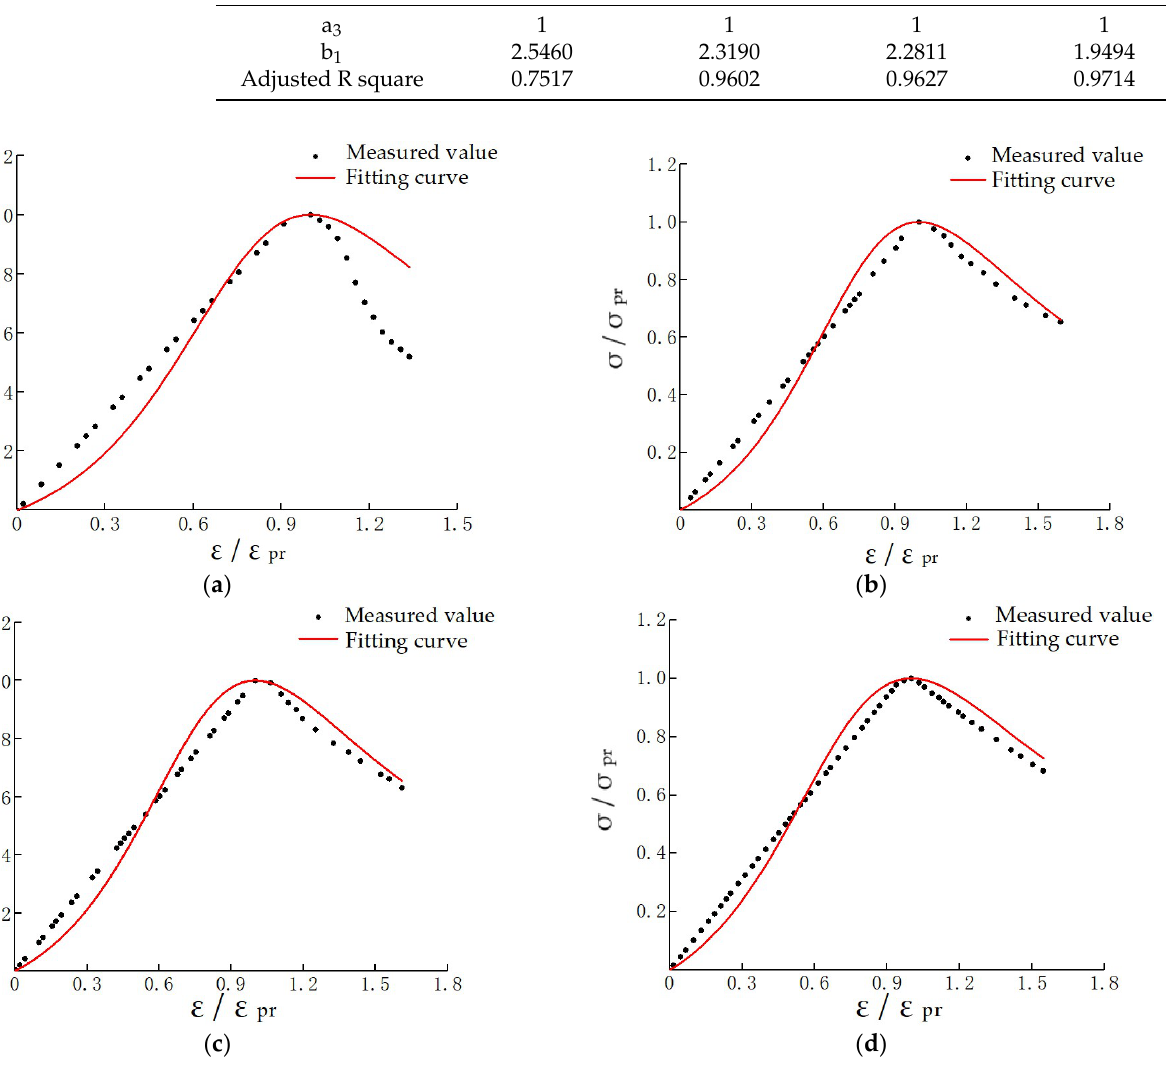
Figure 8. The measured value and curve fitting diagram of cement soil with different fiber content under uniaxial compression. ( a ) fiber content 0%; ( b ) fiber content 0.1%; ( c ) fiber content 0.2%; ( d ) fiber content 0.4%.